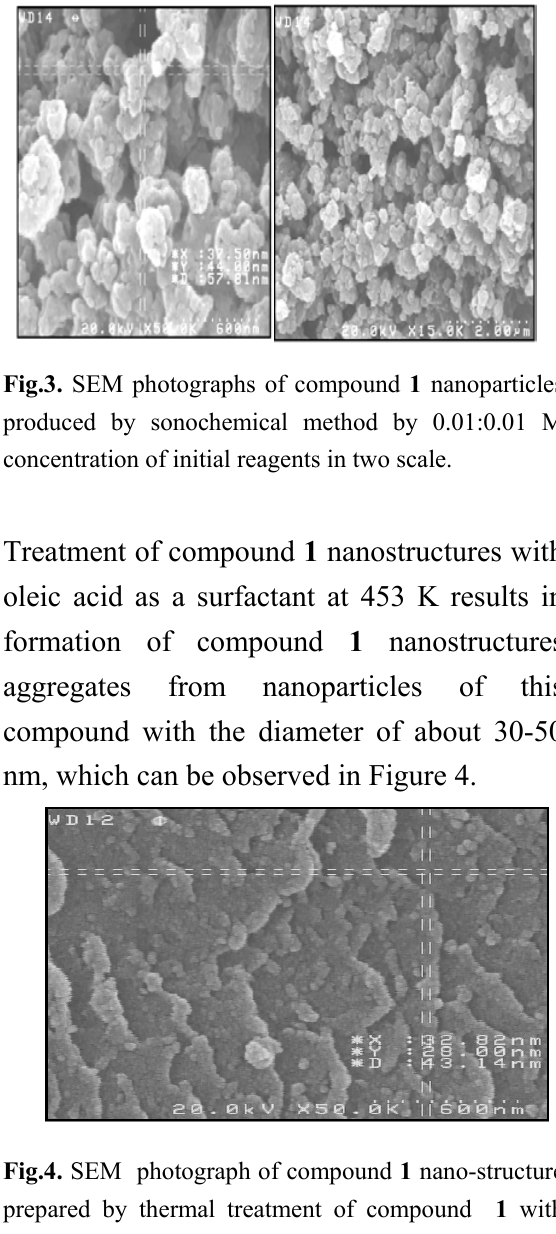
To examine the thermal stability of the compound 1 , thermaogravimetric (TG) and differential thermal analyses (DTA) were carried out between 50 and 900 °C under Argon flow (Figure 5). The compound 1 is stable up to 400 o C. Decomposition of compound 1 occurs between 400 and 450 ºC with a mass loss of 52.82%. Mass loss